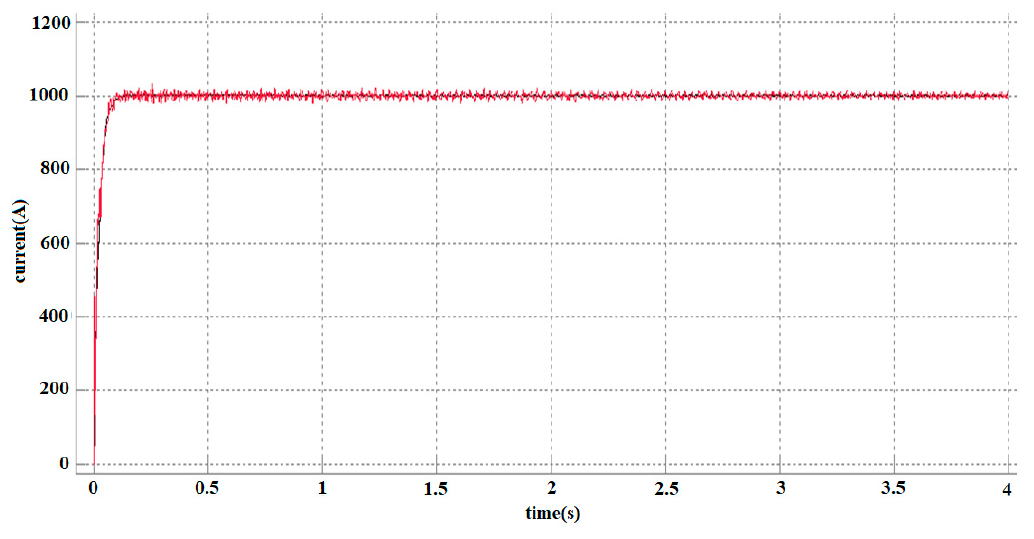
Figure 15. Input-side current tracking of d axis. Electronics 2020 , 9 , 61